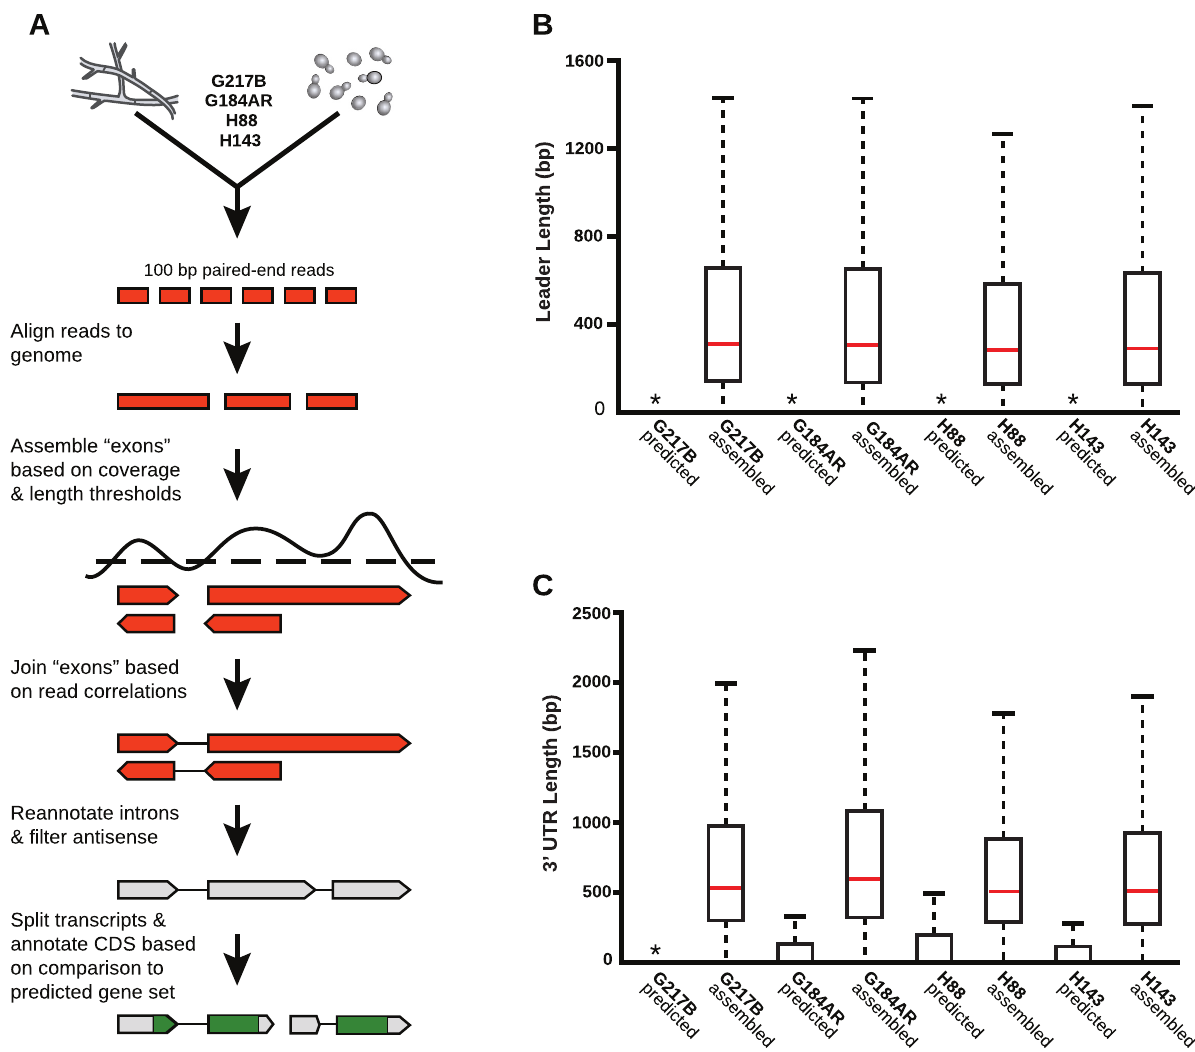
Fig 2. De novo Histoplasma transcriptome reconstruction augments transcript models. (A) Schematic of transcriptome reconstruction method. (B–C) Boxplots of the length of (B) leader regions that were defined as the distance from the 5’ transcript end to the CDS start codon or (C) 3’ UTR regions that were defined as the distance from the CDS stop codon to the 3’ transcript end were plotted for all assembled and predicted transcripts with CDS regions > 0. Boxes, interquartile range (IQR). Whiskers, 1.5 � IQR. For ease of viewing, outliers are not displayed. � , indicates that the predicted transcript leader or 3’ UTR length distributions is not visible on this graph. The predicted transcript leader lengths range from 0–1652 bp and the 3’ UTR lengths range from 0–3112 bp in the 4 Hc strains.